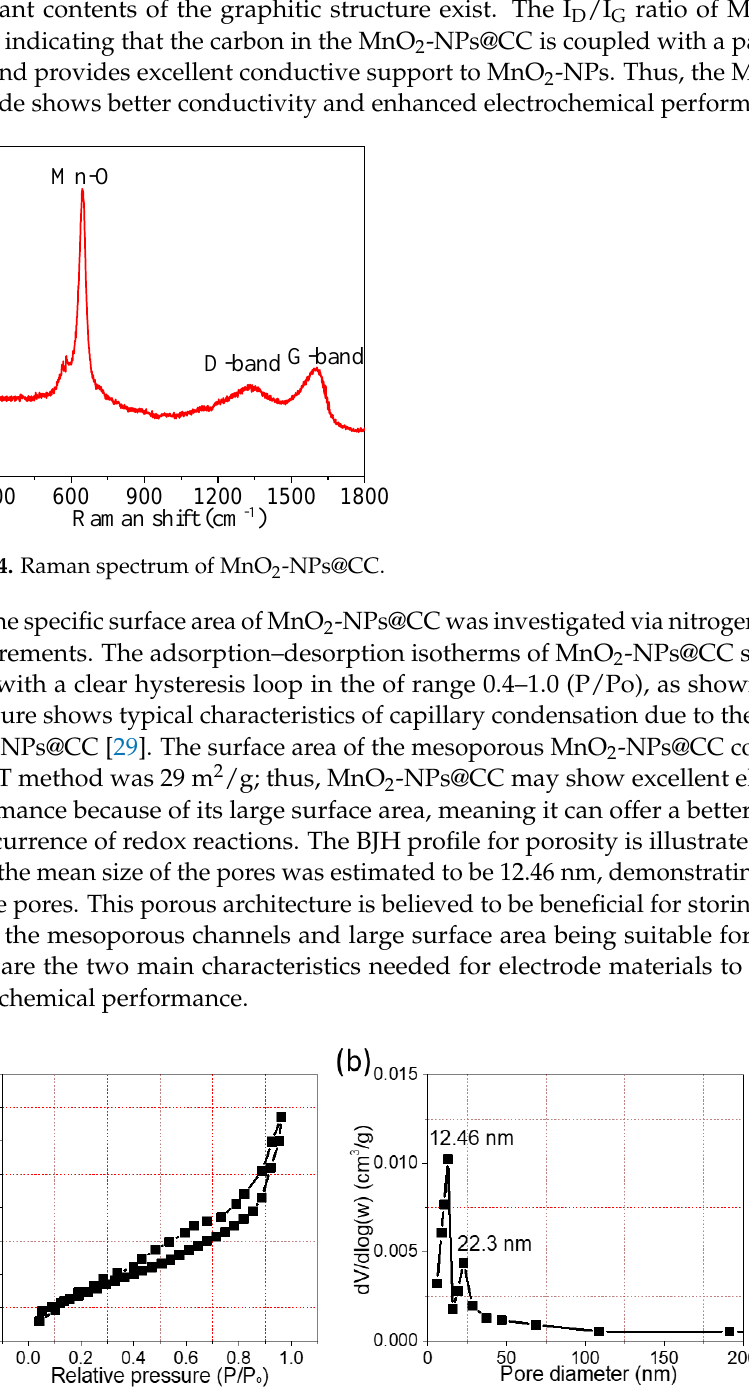
(1) where m (g) indicates the mass, I (A) represents the current, Δ t (s) indicates the discharge time, and Δ V (V) represents the potential window [31]. The specific capacitance was 660 F/g with a current rate of 2 A/g (Figure 6e). By increasing the current rate from 2 to 32 A/g, the MnO 2 -NPs@CC electrode showed 58% capacitance retention, which indicated the excellent rate capability. The capacitance decreased at higher current rates owing to the short time for the diffusion of electrolyte ions into the interior section of the electrode material, so the reduced diffusion decreased the capacitance. The electrochemical impedance spectroscopy (EIS) experiment was performed to investigate the conductivity and diffusion performance of the MnO 2 -NPs@CC electrode. The Nyquist plot consists of a semi-circular portion in a high-frequency region and a quasi-vertical line in a low- frequency region (Figure 6f). This linear portion corresponds to the remarkable electrochemical capacitive response of MnO 2 -NPs@CC and the semicircle’s radius